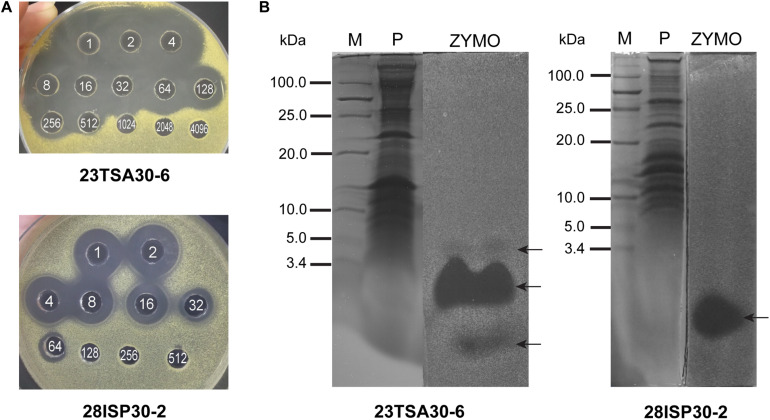
Characterization of proteinaceous antibacterial compounds. (A) An agar-well diffusion assay of crude preparations. The white numbers in the wells denote the dilution of the crude preparation. (B) Comparison of T-SDS-PAGE gel and zymogram of crude preparations. M, PageRuler Unstained Low Range Protein Ladder (Thermo Fisher Scientific); P, T-SDS-PAGE gel; ZYMO, zymogram. The test strain M. luteus Sar1 was used as an indicator for this analysis. The zones of antimicrobial activity against the test strain are indicated by black arrows.